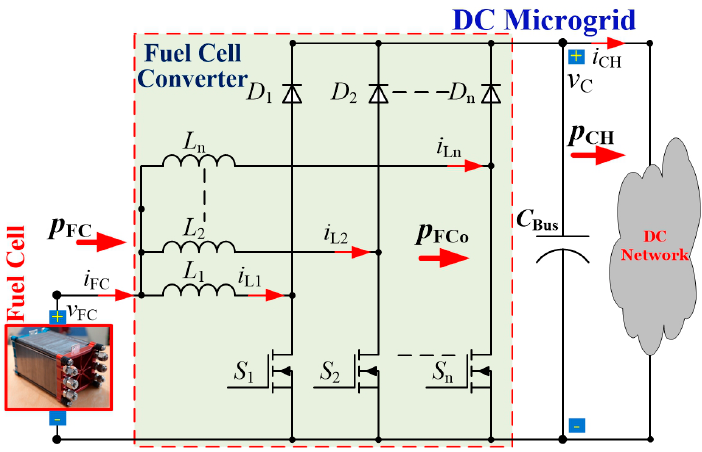
Figure 2. Multiphase parallel step-up converters for fuel cell (FC) main source in DC microgrid applications.